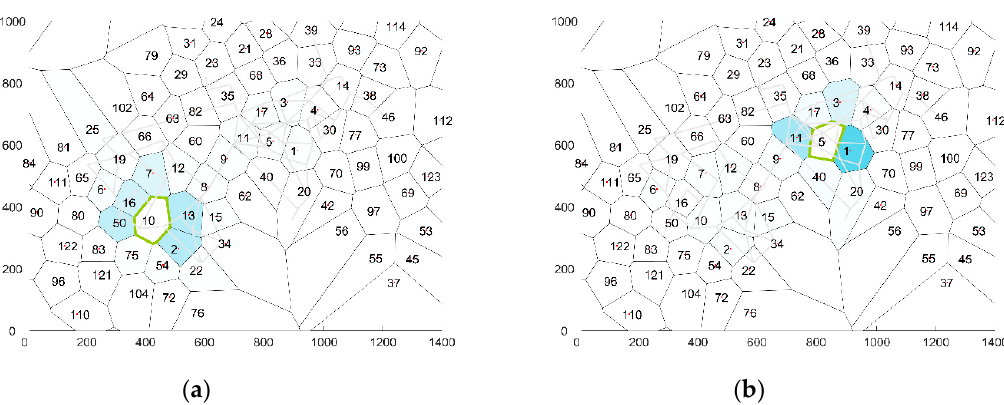
Figure 5. Visualization of the average transition probabilities towards other cells for ( a ): cell 10 and ( b ) cell 50.